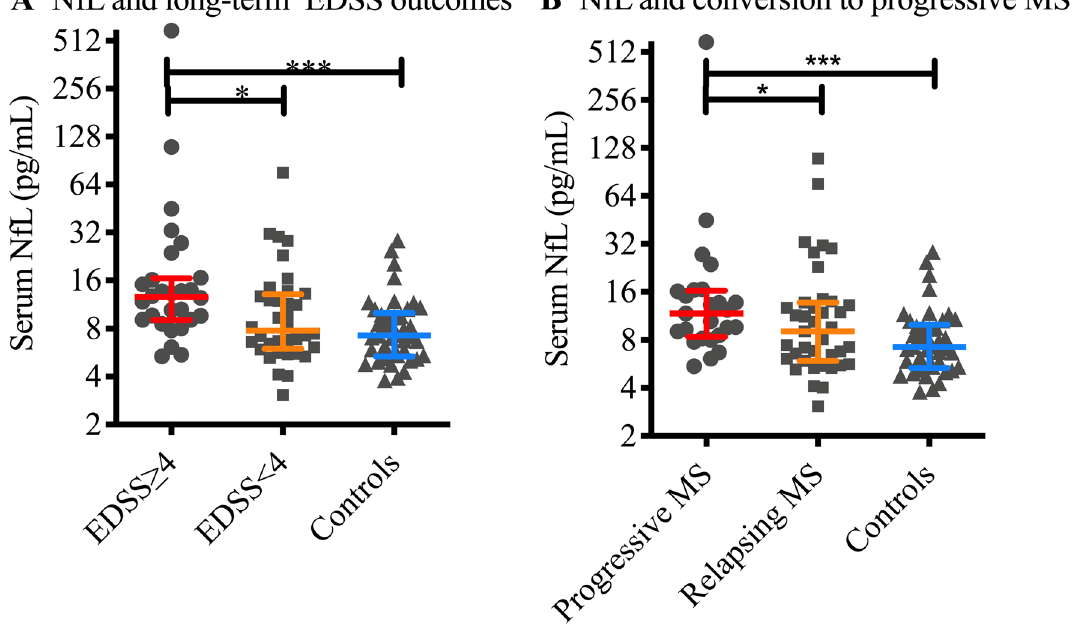
Figure 3. Raw serum NfL levels and subsequent disease progression. Serum NfL levels were higher in patients who reached EDSS ≥ 4 compared to those who had an EDSS < 4 ( p = 0.0094, A ) and controls ( p = 0.0001), although was no significant difference comparing EDSS < 4 to controls. Similarly, baseline sNfL levels were higher in MS patients compared to controls, both in patients who developed progressive disease ( p = 0.0005, B ) and patients with relapsing disease ( p = 0.041). Y axis scale is Log(2) to most accurately represent the distribution of the data. Lines and bars depict median and interquartile